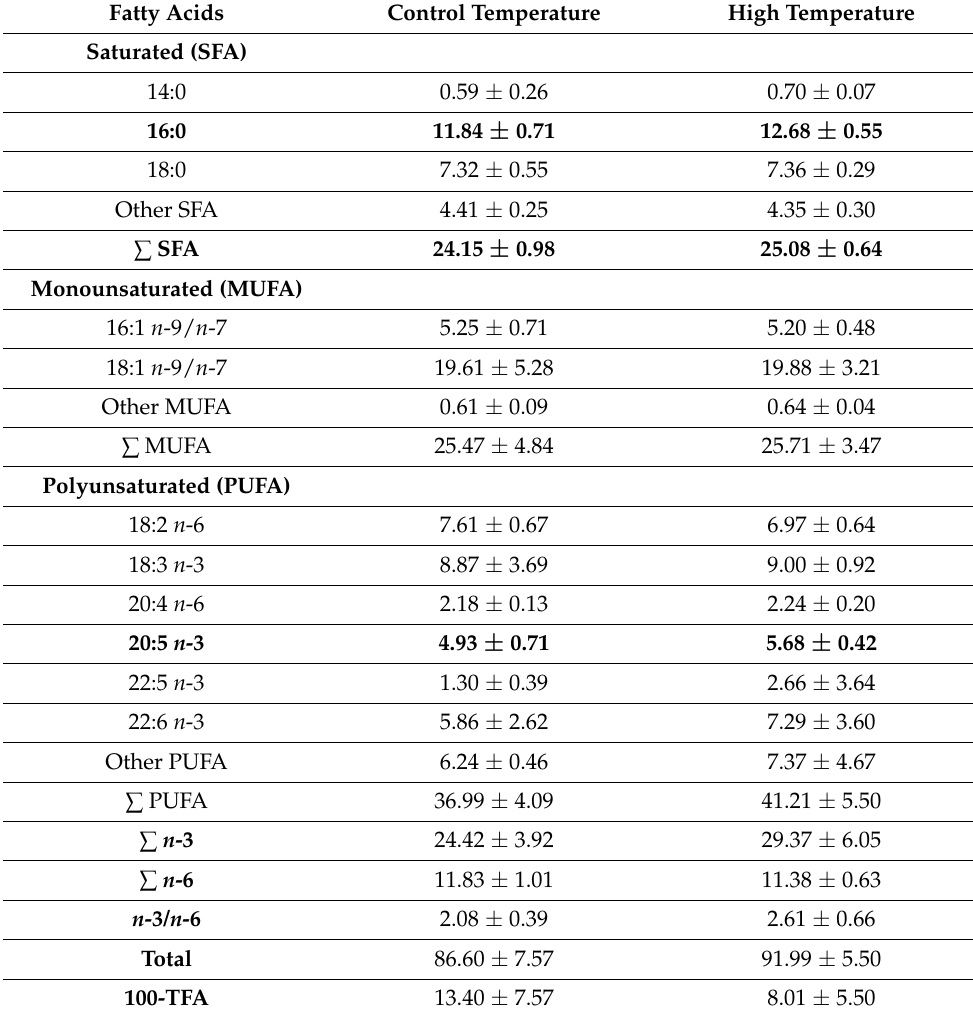
Table 5. Fatty acid composition (% of total FA) on eggs of two-spotted goby, Pomatochistus flavescens in Control (CT) and High (CT) temperature treatments (mean ± s.e.). Fish under low ration did not reproduce. Bold text indicates significant differences between temperatures in fatty acid composition. Fatty Acids Control Temperature High Temperature Saturated